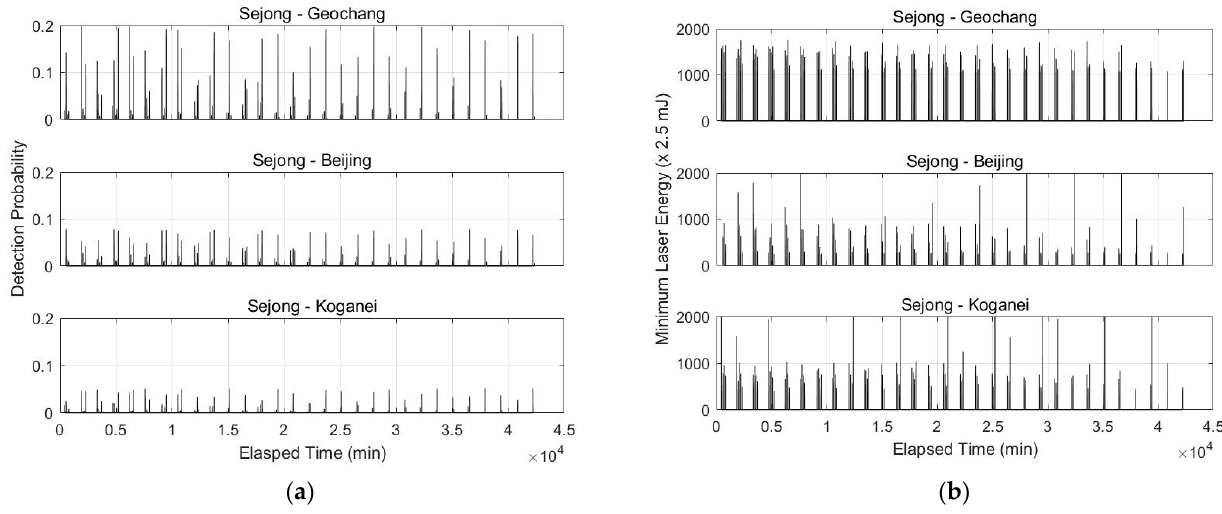
Figure 6. Time series of ( a ) detection probability and ( b ) minimum laser energy corresponding to threshold of detection probability.